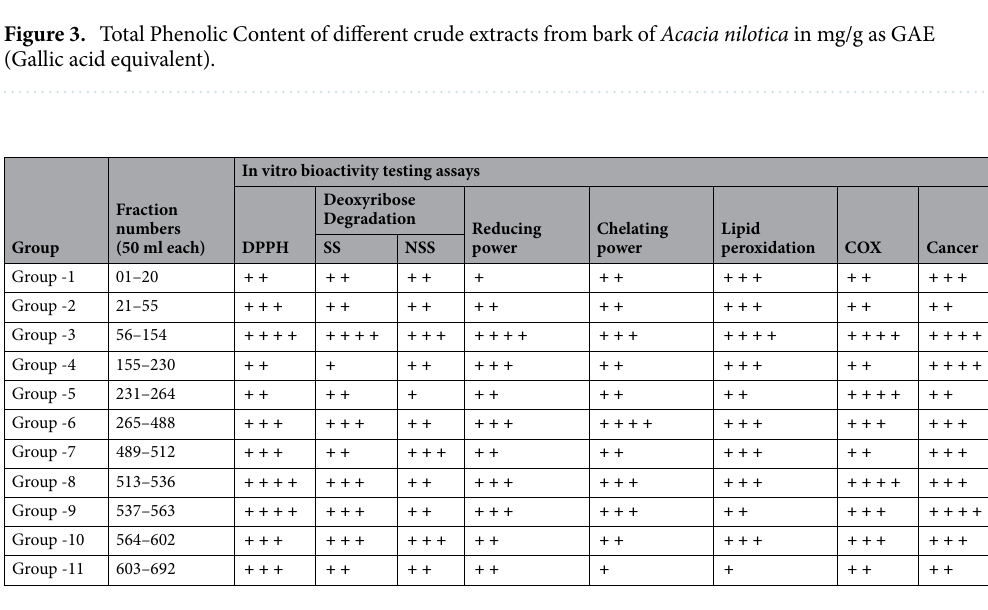
Table 1. Bioassay guided fractionation based biological activities of fractions collected from methanol extract of Acacia nilotica through column chromatography. SS: Deoxyribose Site specific assay; NSS: Deoxyribose non- site specific assay. Activity percentage (%) range: + : 0–25%, + + : 25–50%, + + + : 50–75%, + + + + : 75–100%.